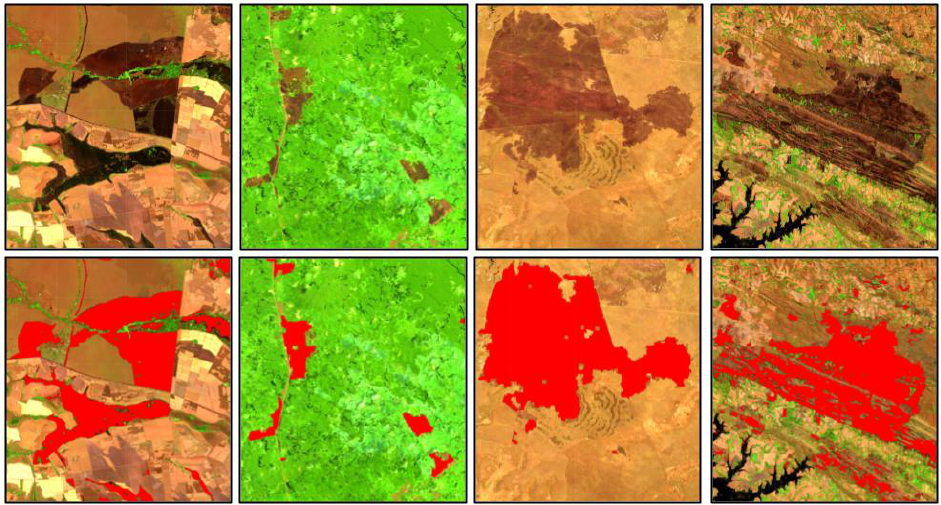
Figure 6. Examples of the burned areas classification for different types of fire, with the Landsat mosaic used for classification, and the area classified as burned in red.